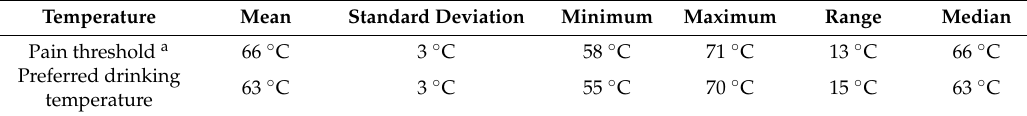
Table 1. Summarized results of the pilot study ( n =